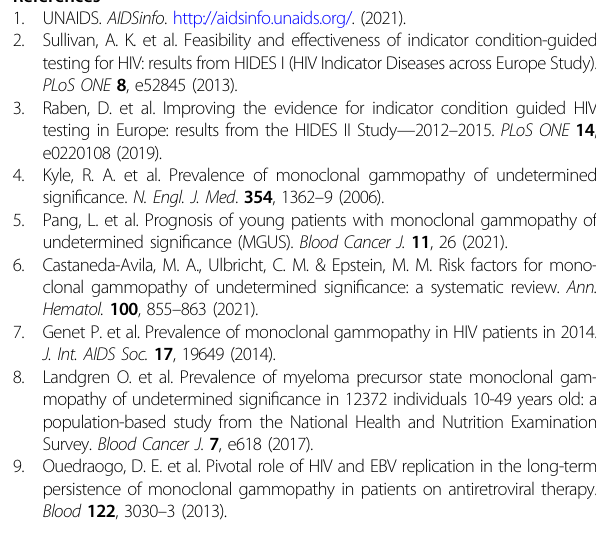
routinary blood cell count test and con fi rmed in at least two consecutive determinations.